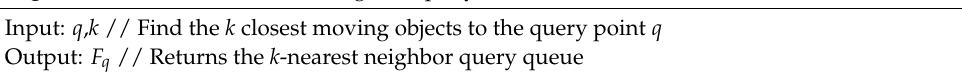
Algorithm 1. The first k -nearest neighbor